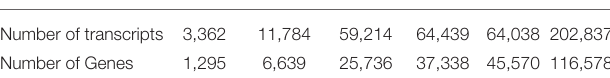
TABLE 2 | Statistical table of length frequency distribution before and after transcript de-redundancy.